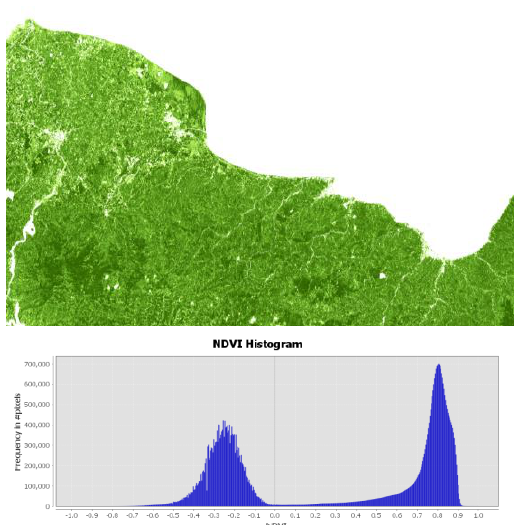
Figure 9. NDVI image (above) of DS4 and its histogram (below).